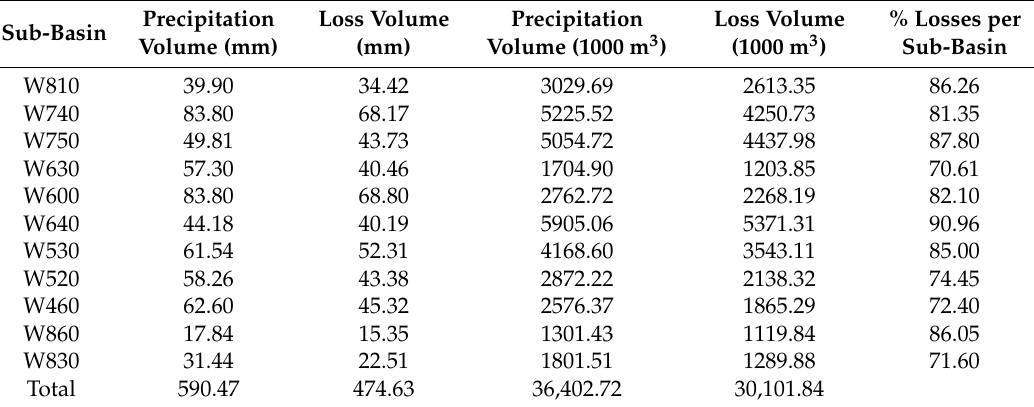
Table 11. Basin losses of 1972.